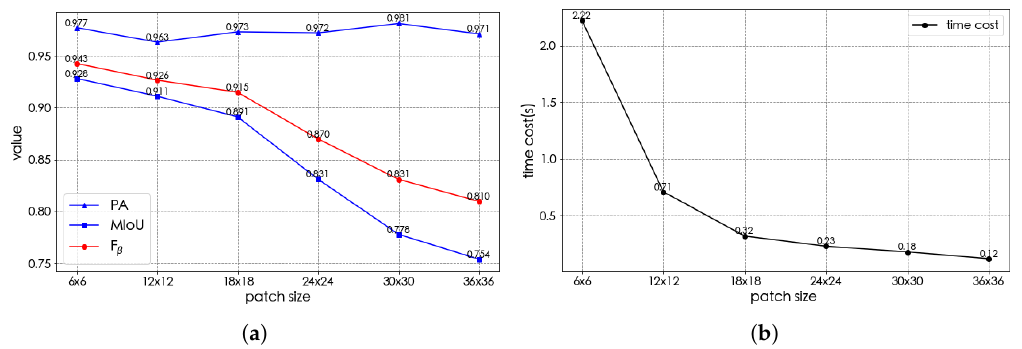
Figure 16. Performance of the proposed algorithm under using different patch sizes. ( a ) PA , MIoU and F β under different patch sizes. ( b ) Speed under different patch